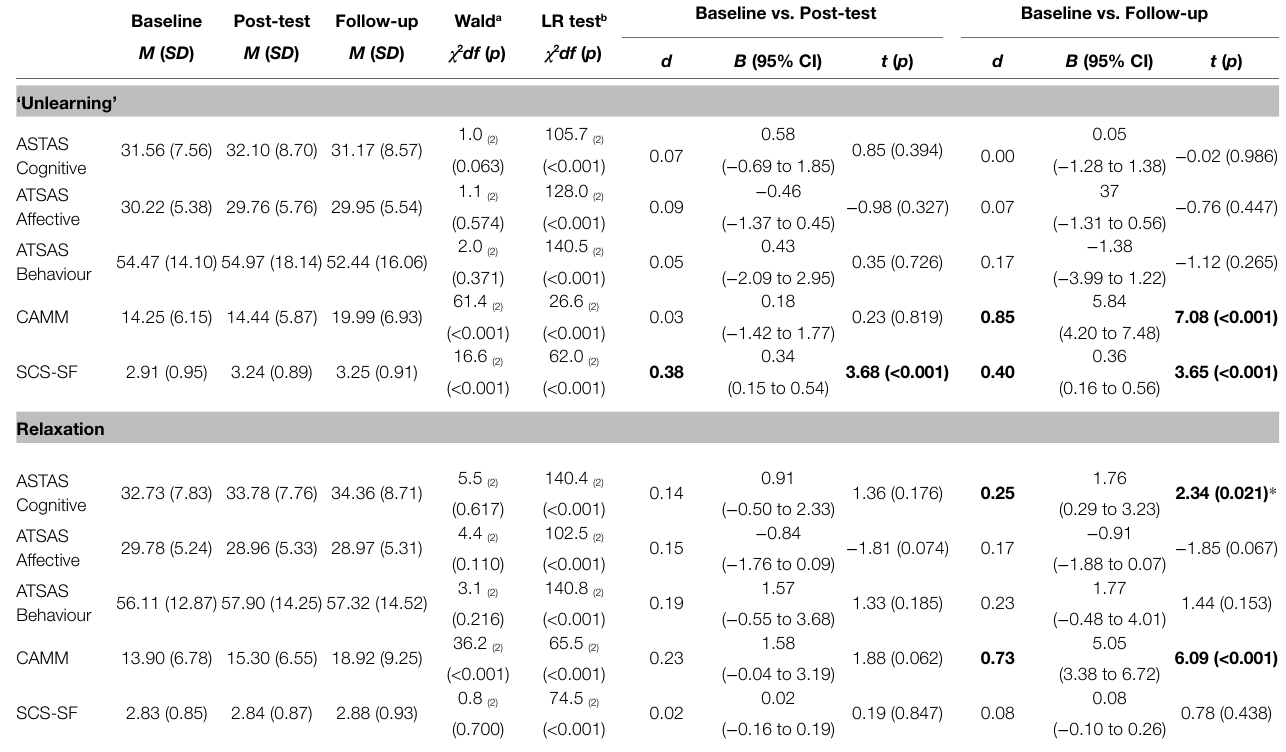
Baseline vs. Post-test